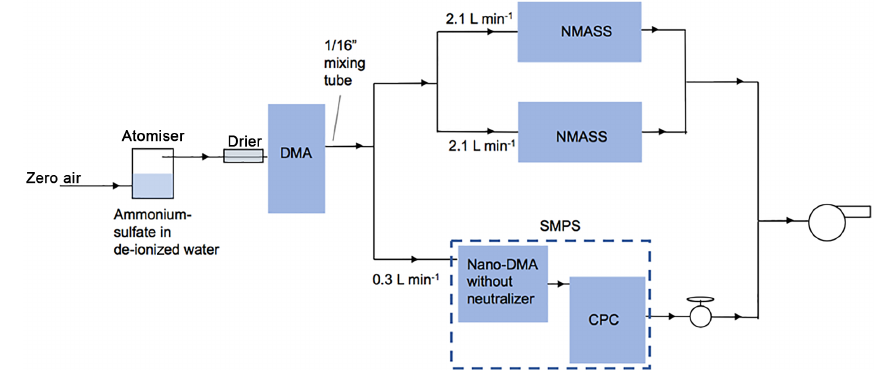
Figure 9. Set-up for checking the NMASS inversion against an SMPS. Atomized ammonium sulfate is dried and passed to a DMA, which selects a narrow range of particle sizes. A 1 / 16in. tube is used after the DMA to ensure the sample flow is well mixed (the Reynolds number of the flow, Re > 4000) before splitting it between an SMPS (composed of a nano-DMA coupled with a CPC) and the two NMASSs. The length of tubing to the SMPS and NMASS systems are proportional to the flow through them to ensure the sample experiences the same diffusion losses before being measured. An external pump is used behind the CPC to handle the low upstream pressure caused by 1 / 16in. tubing after the first